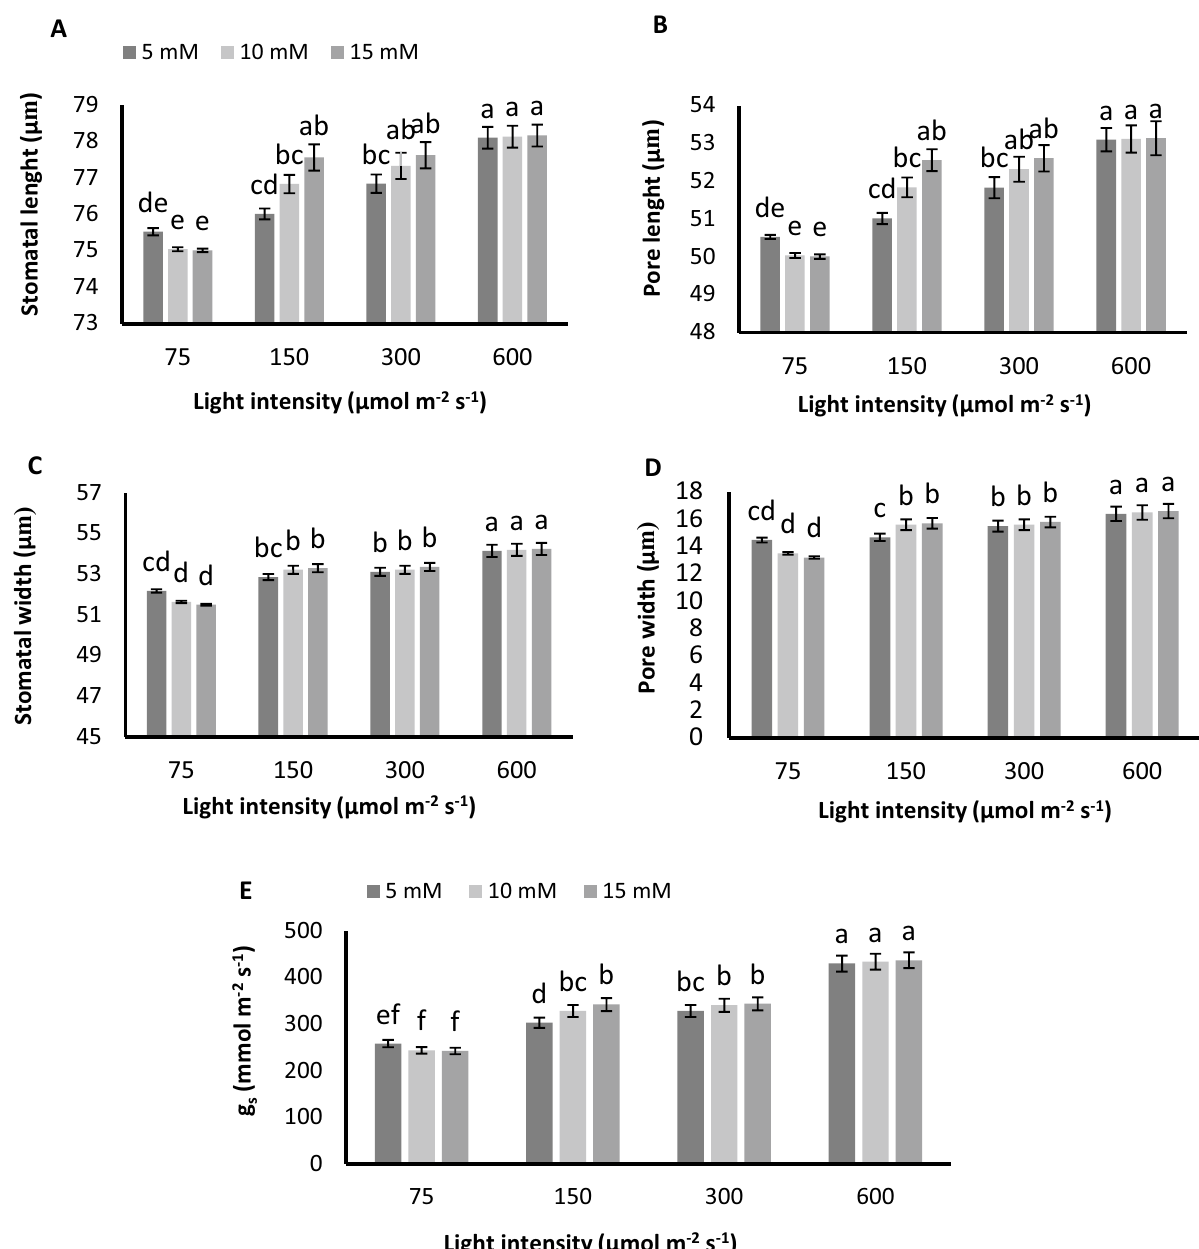
Figure 3. Stomatal lenght ( A ), stomatal pore lenght ( B ), stomatal width ( C ), stomatal pore width ( D ), and stomatal conductance (g s ) ( E ) of chrysanthemum plants grown under different light intensits (75, 150, 300, and 600 µmol m −2 s −1 ) and nitrogen (N) concentrations (5, 10, and 15 mM N) at 70 days of cultivation. Vertical bars are means ± SD. Within each graph, interactive effects of light intensity and nitrogen concentration are shown. Different letters (a–d) denote a significant difference between treaments (P <